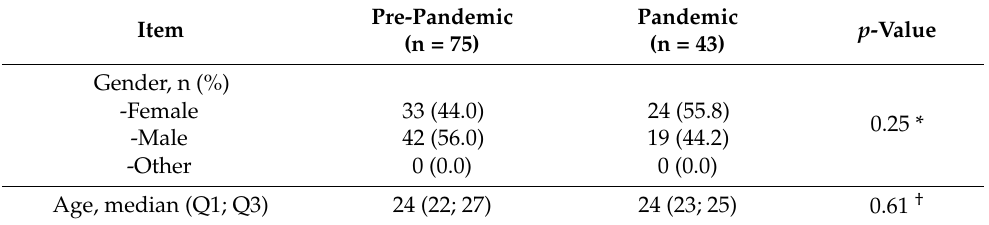
Table 1. Characteristics of students included in primary outcome analysis, by